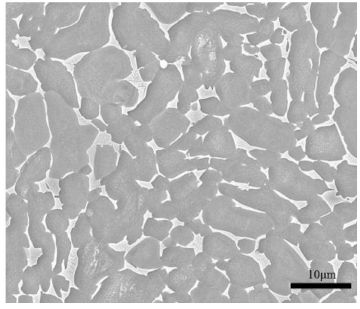
Figure 1. Starting microstructure of the Ti-6Al-4V